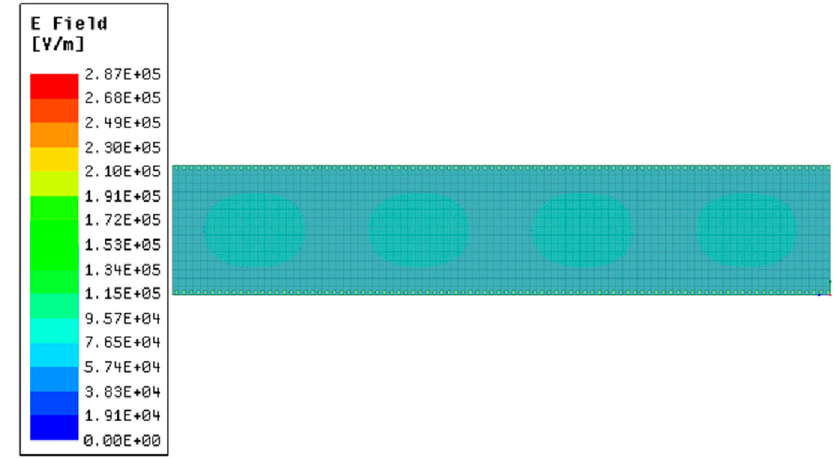
Figure 4. Discretized SIW operating under mode TE 4,1 . Electric field discretized for 28 GHz using nonmodel object cells of 0.3 mm side in Ansys HFSS.